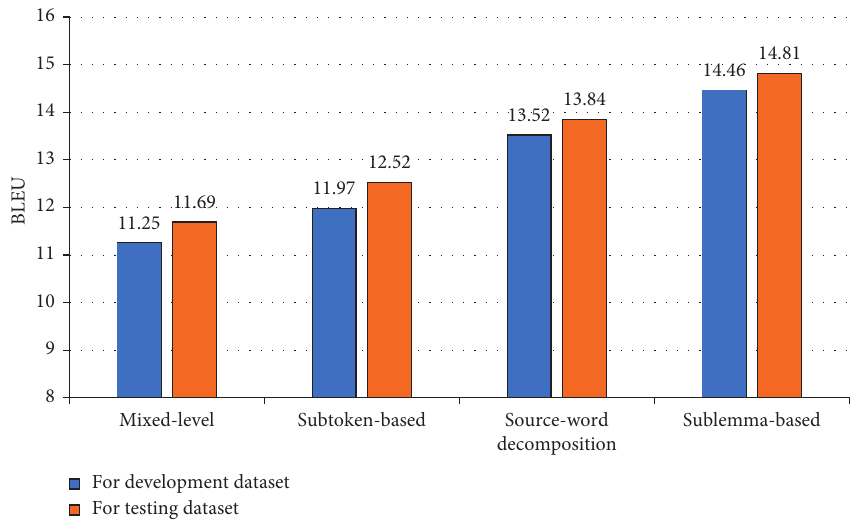
Figure 1: BLEU scores of comparative Transformer models. Table 6: First case study with correct